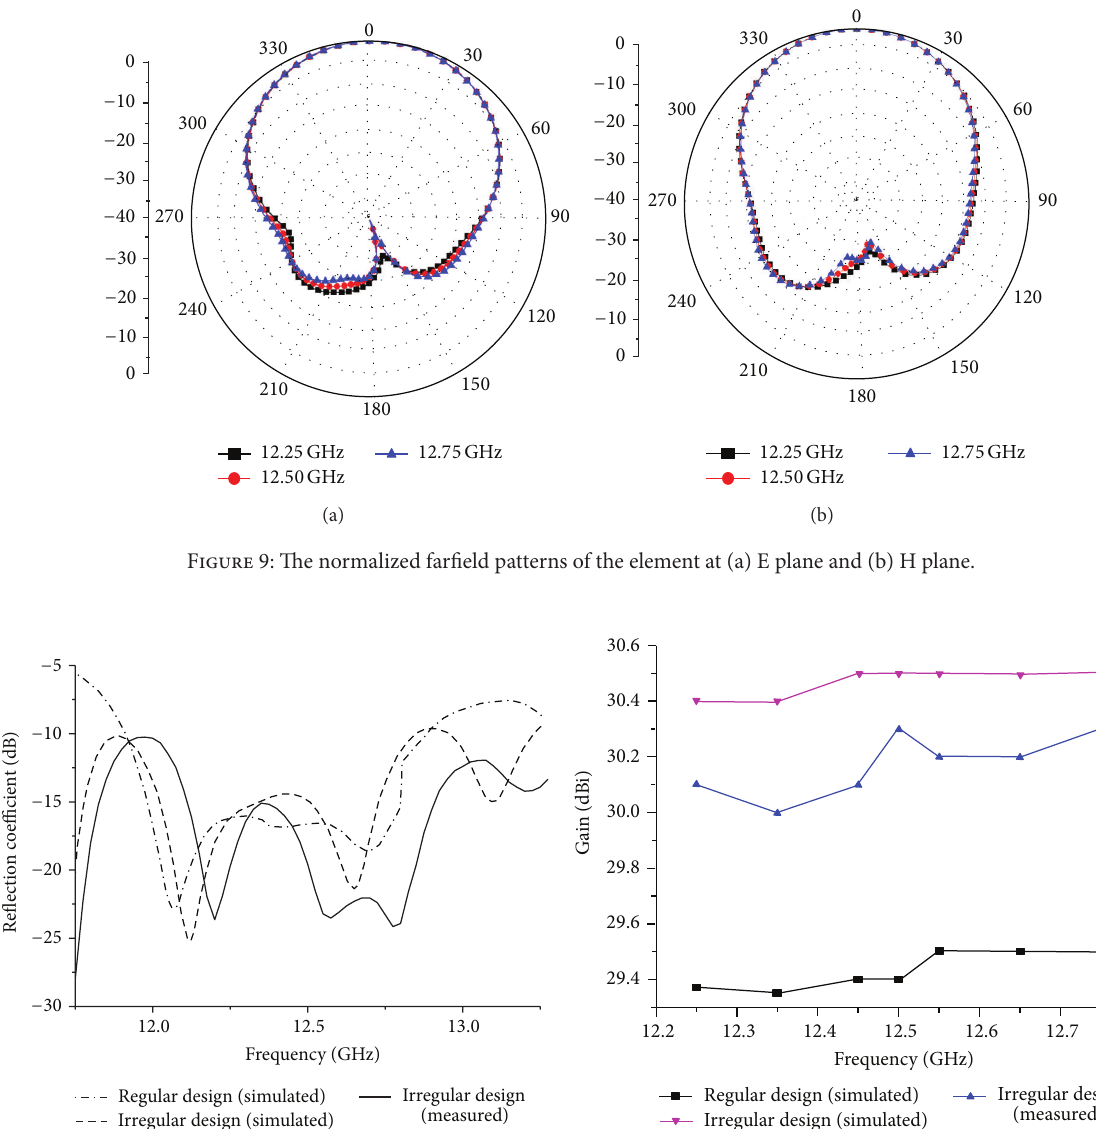
Regular design (simulated) Irregular design (simulated)